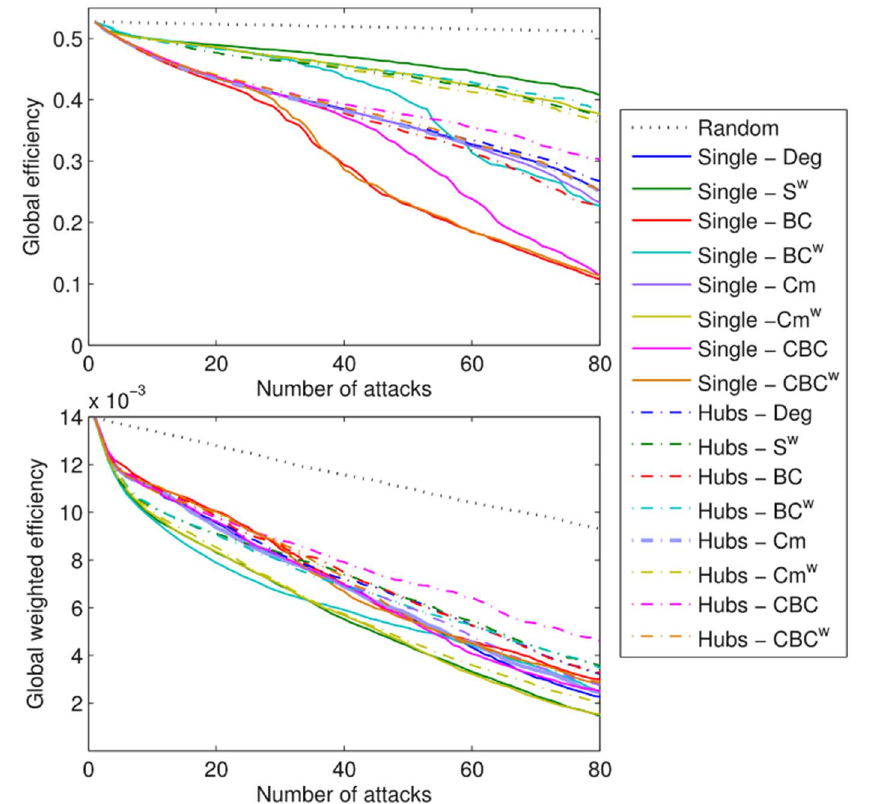
Fig. 3. Average efficiency decay (Eff, Eff w ) curves over subjects for the different target selection strategies. Curves are reported for a total of N 5 80 consecutives attacks.